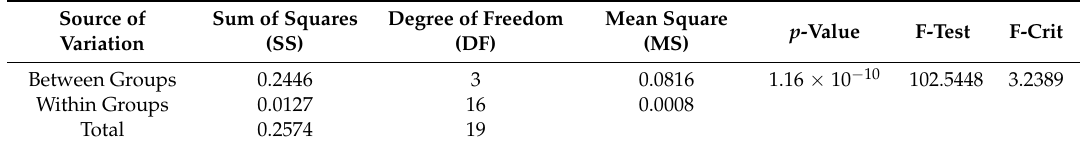
Table 4. One-way ANOVA test for PE at scale 2 of